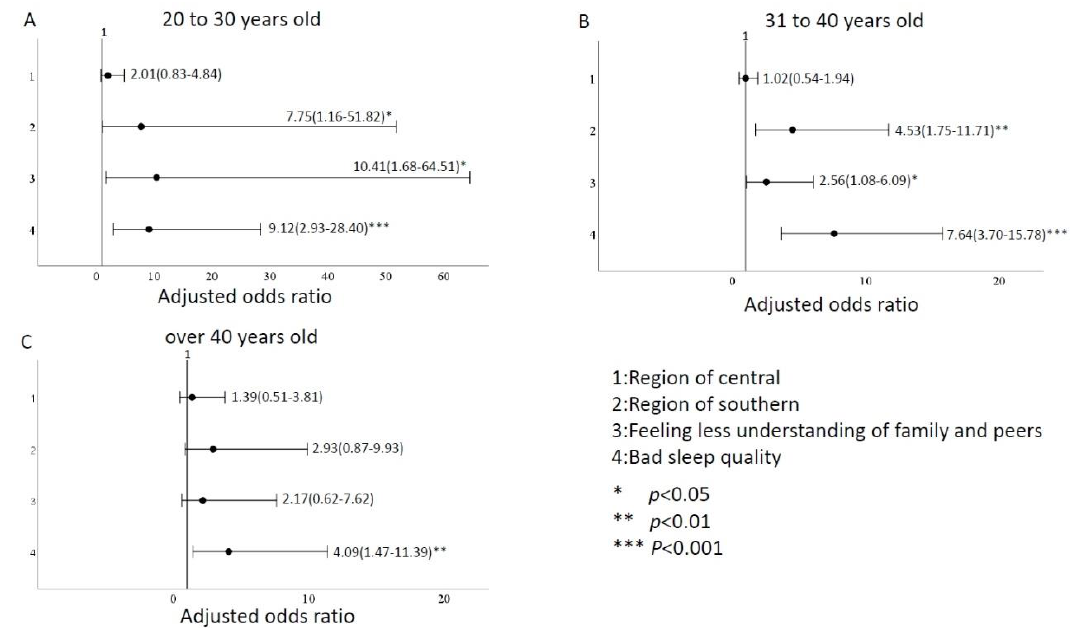
Figure 2. Comparison of odds ratio factors for depression levels at different ages. ( A ) between 20 – 30 years old ( B ) between 31 – 40 years old ( C ) over 40 years old.